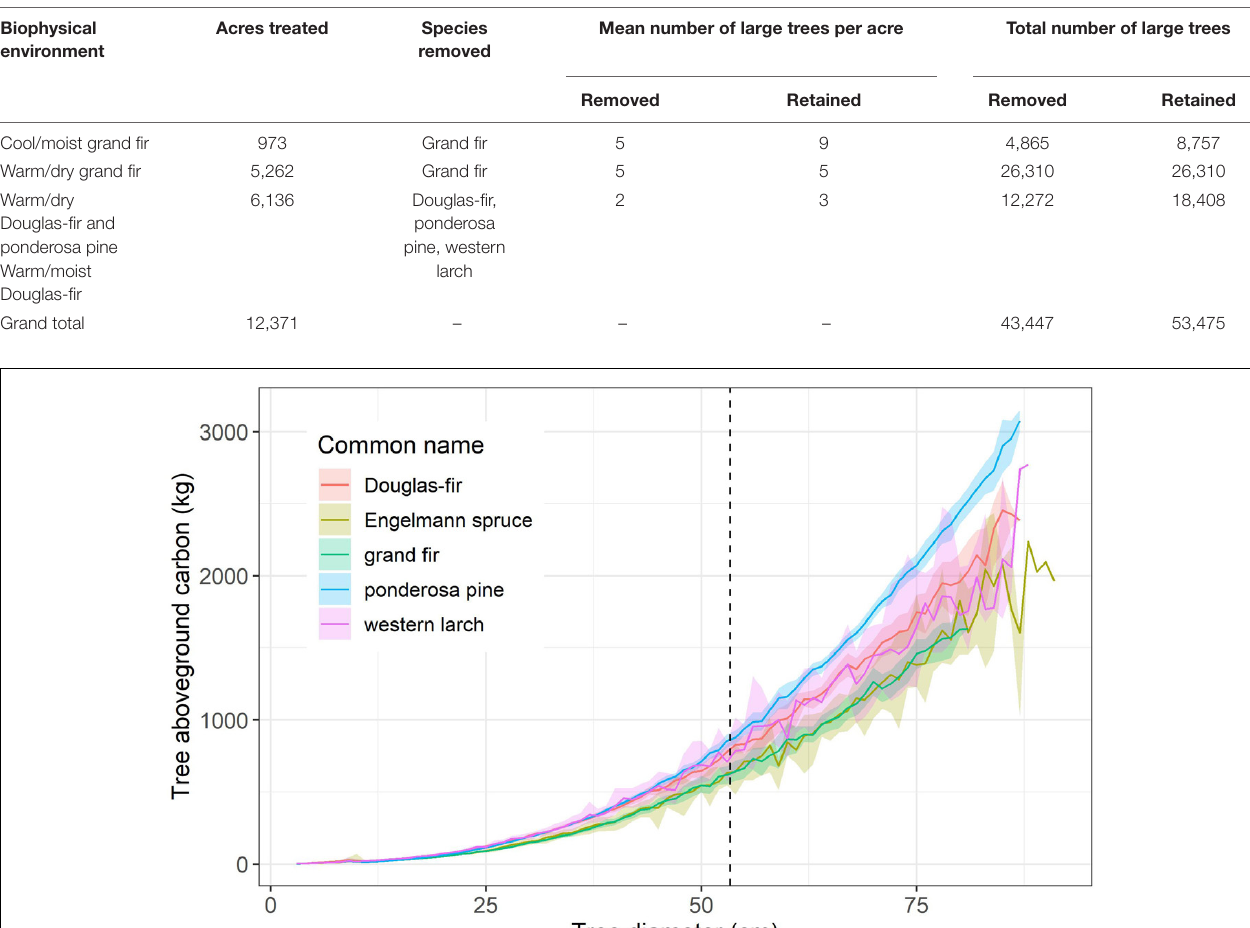
TABLE 2 | The total number of trees ≥ 21 in DBH proposed for removal and retention across the Snow Basin project area as reported in the NEPA plan prepared by the USFS (Table 53 of Snow Basin Vegetation Management Project DEIS, 2011).